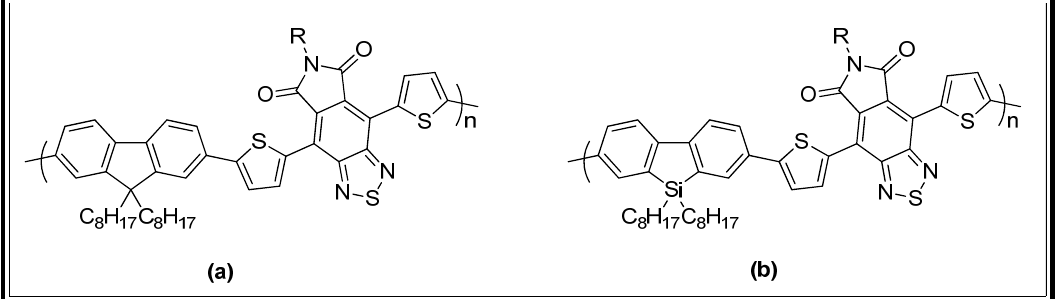
Figure 21. Molecular structures of: ( a ) PFDTBTDI-DMO and PFDTBTDI-8; ( b ) PDBSDTBTDI-DMO and PDBSDTBTDI-8.